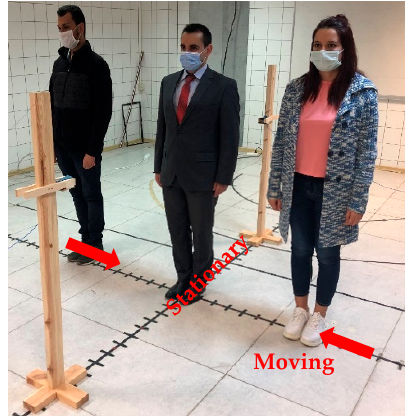
Figure 2. Measurement scenario.